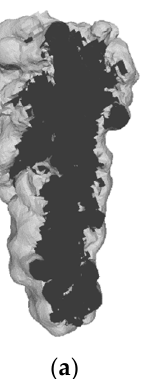
Figure 7. ( a ) Example of mesh prior to reconstruction, and ( b ) the same mesh after Poisson reconstruction.